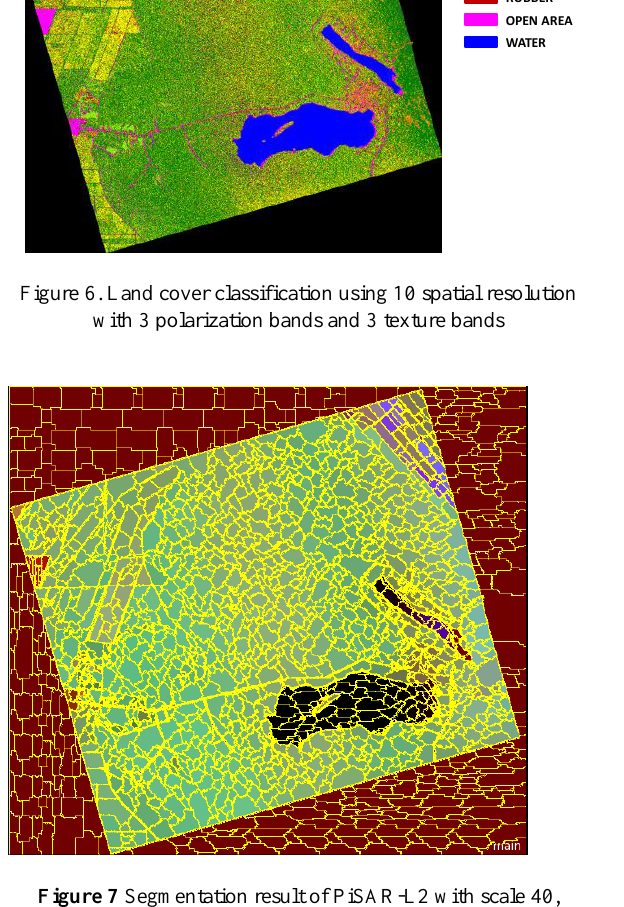
Figure 7 Segmentation result of PiSAR-L2 with scale 40, colour 0.5 and shape 0.5